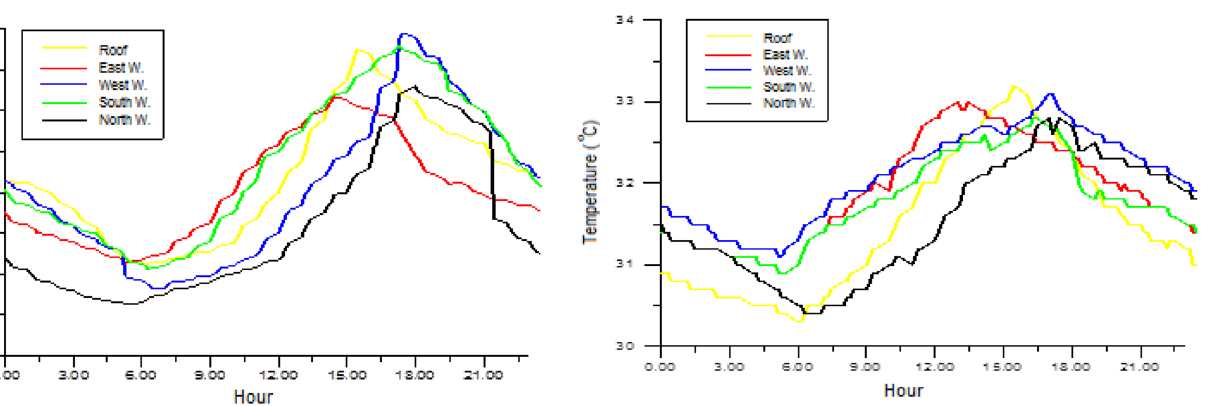
Fig. 4. Internal surface temperature in the traditional model (15-08-2013).